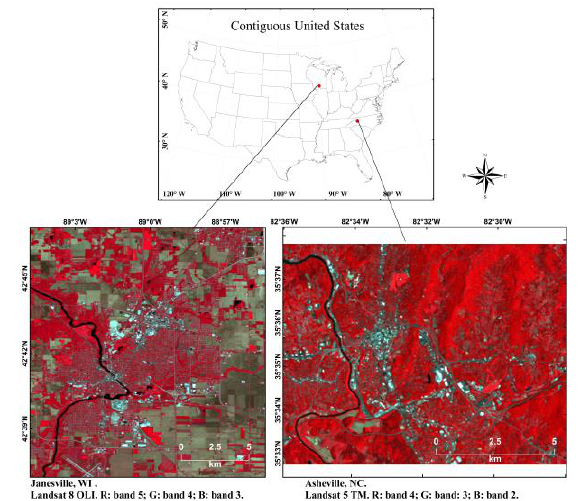
Figure 1. Study areas of Janesville WI, and Asheville